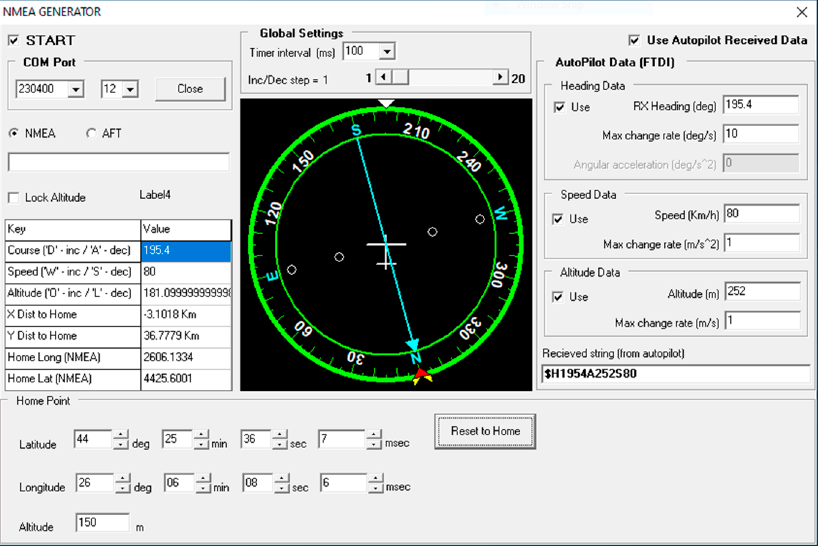
Figure 11. NMEA—based Simulator.